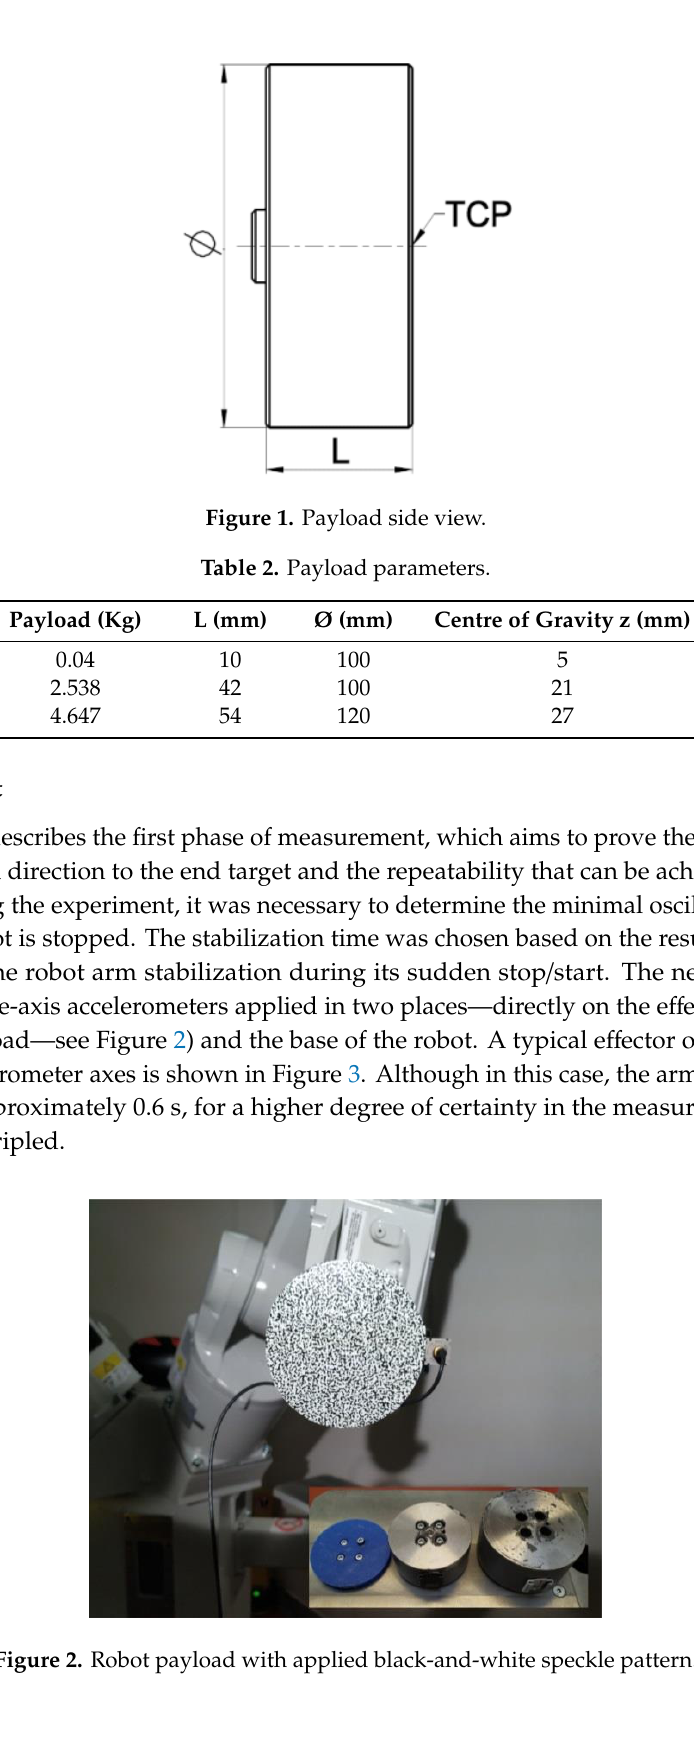
Figure 2. Robot payload with applied black-and-white speckle pattern.